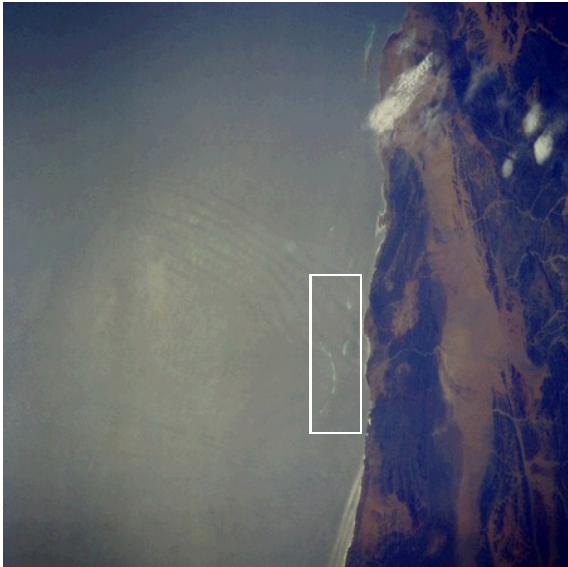
Fig. 3. Satellite image of group of internal solitons in the Red Sea. NASA photo STS41G-36-34 (rotated left) (26 . 5 ◦ N, 36 . 0 ◦ E; 6 Oc- tober 1984; 12:00:47UTC). Contrast balance was changed.